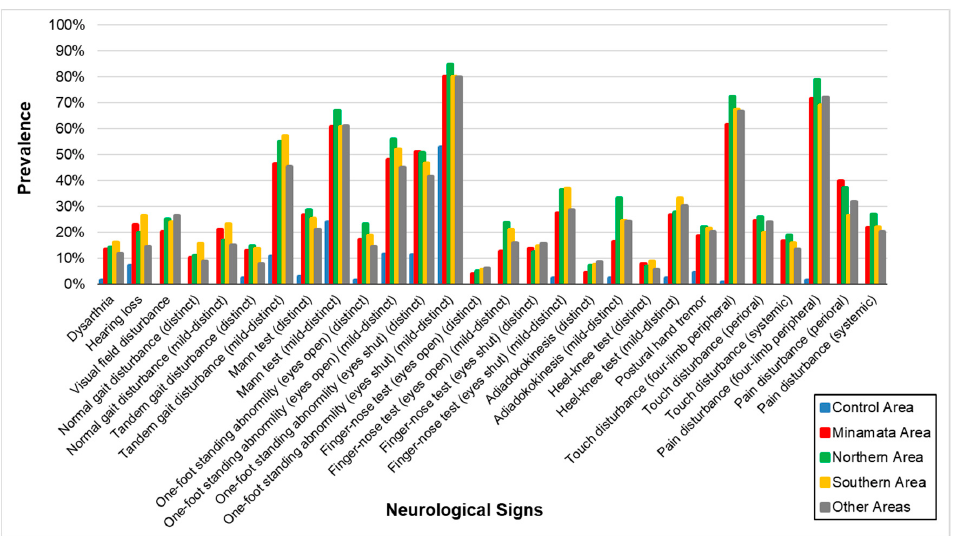
Figure 4. Prevalence of neurological signs in each area. Prevalence was higher in the four exposed groups than that in the control area. The patterns of signs were similar among the four groups. Table 8. Correlation of prevalence of neurological findings among each